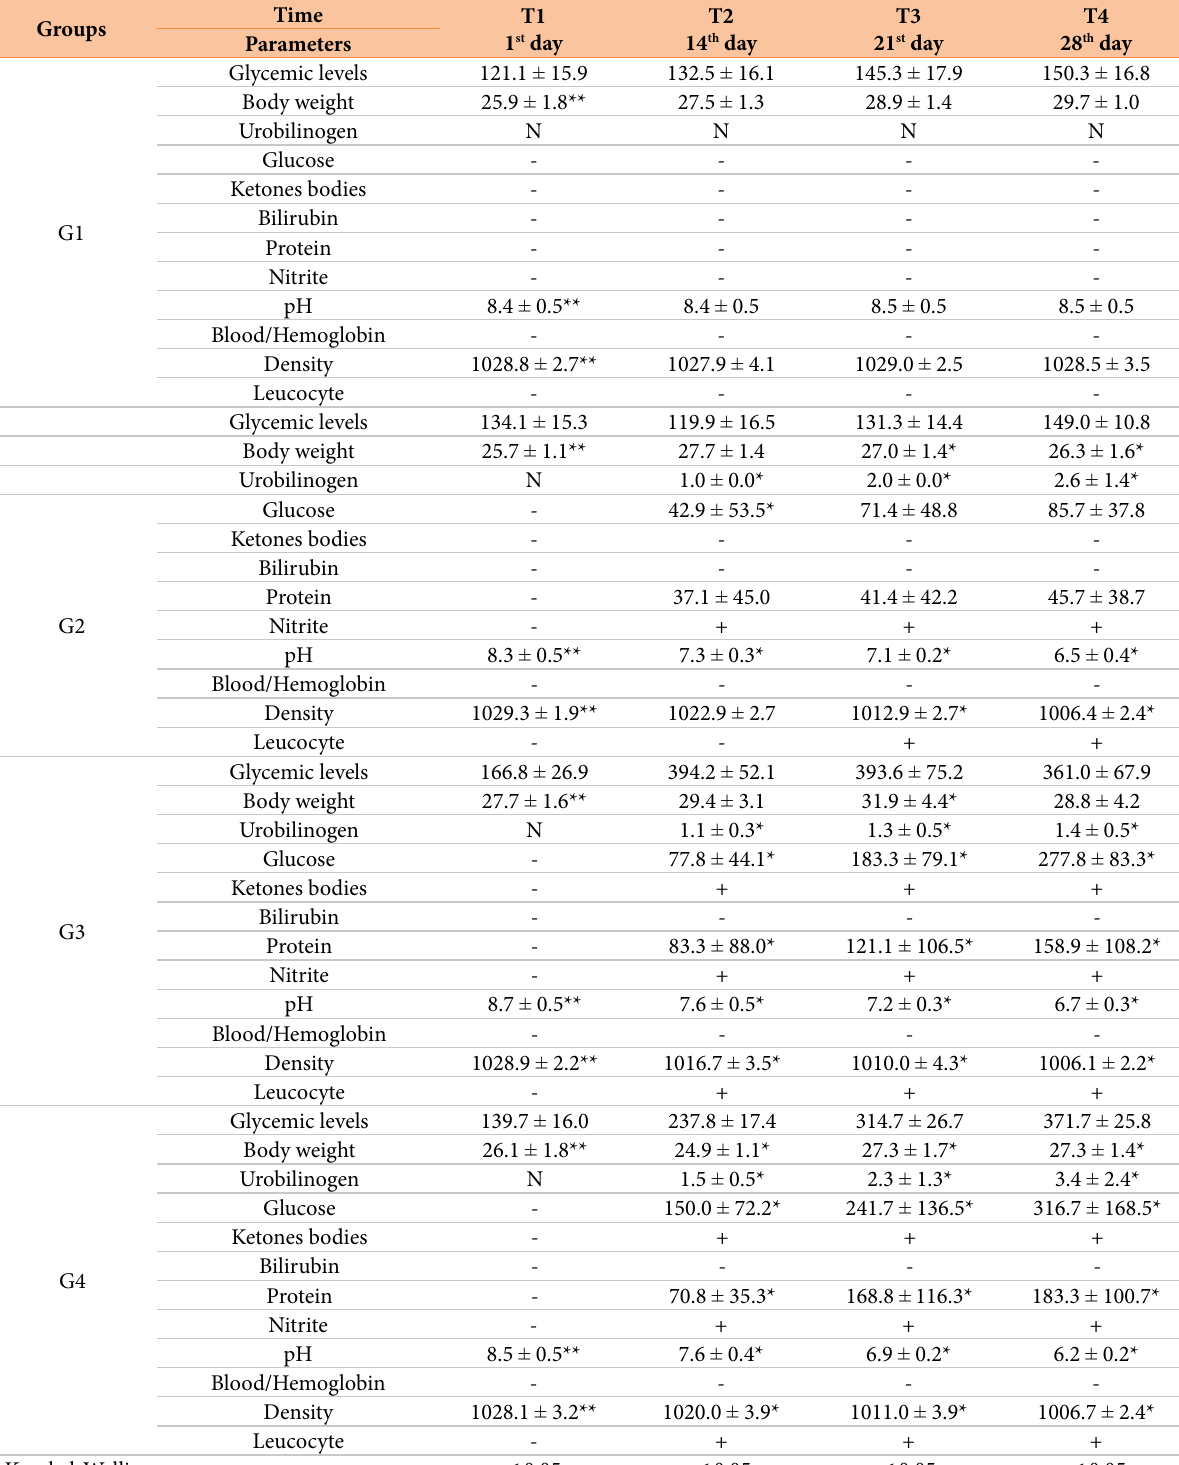
Table 1 – Glycemic levels, Body Weight and Values of urine analysis parameters.